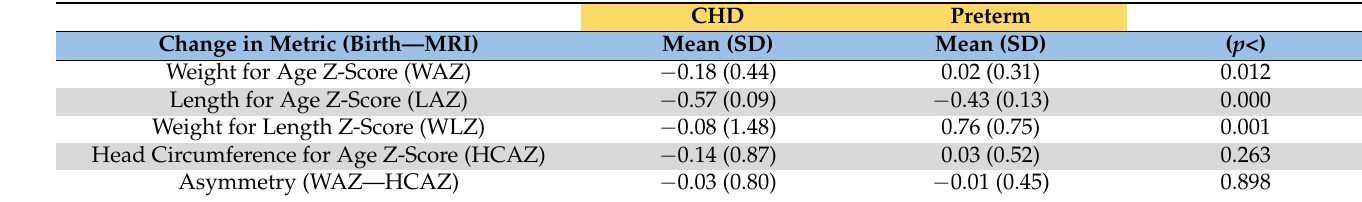
Table 1. Change in standardized growth parameter Z-Scores from birth to time of MRI. Each growth parameter converted to a standardized z-score and normalized for time interval. Preterm-born neonates show a general positive increase in z-score, while CHD neonates show a continued decrease in growth parameter for